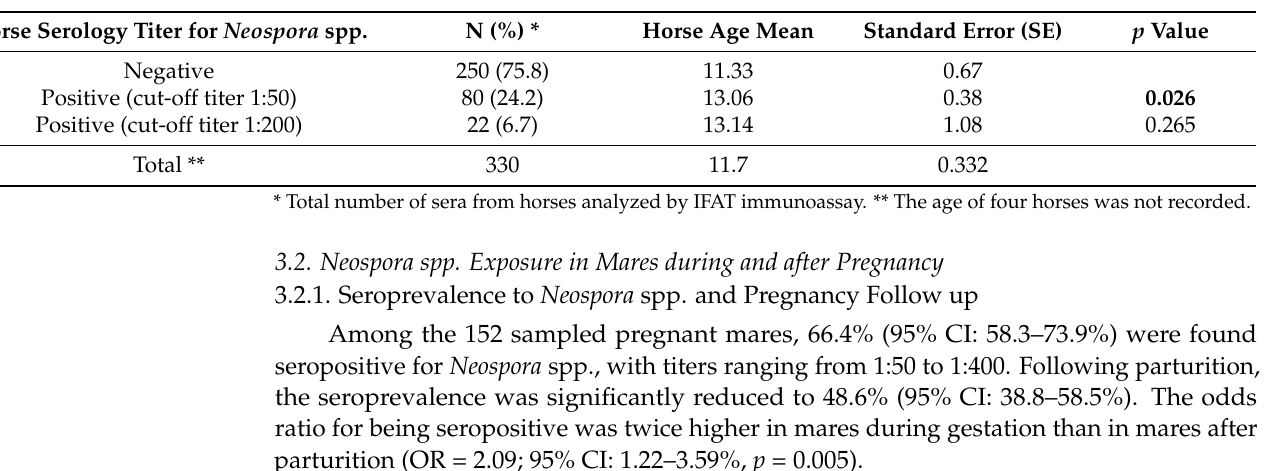
Table 2. Neospora spp. seroprevalence in the first study population of apparently healthy horses detected by IFAT in relation to horse’s